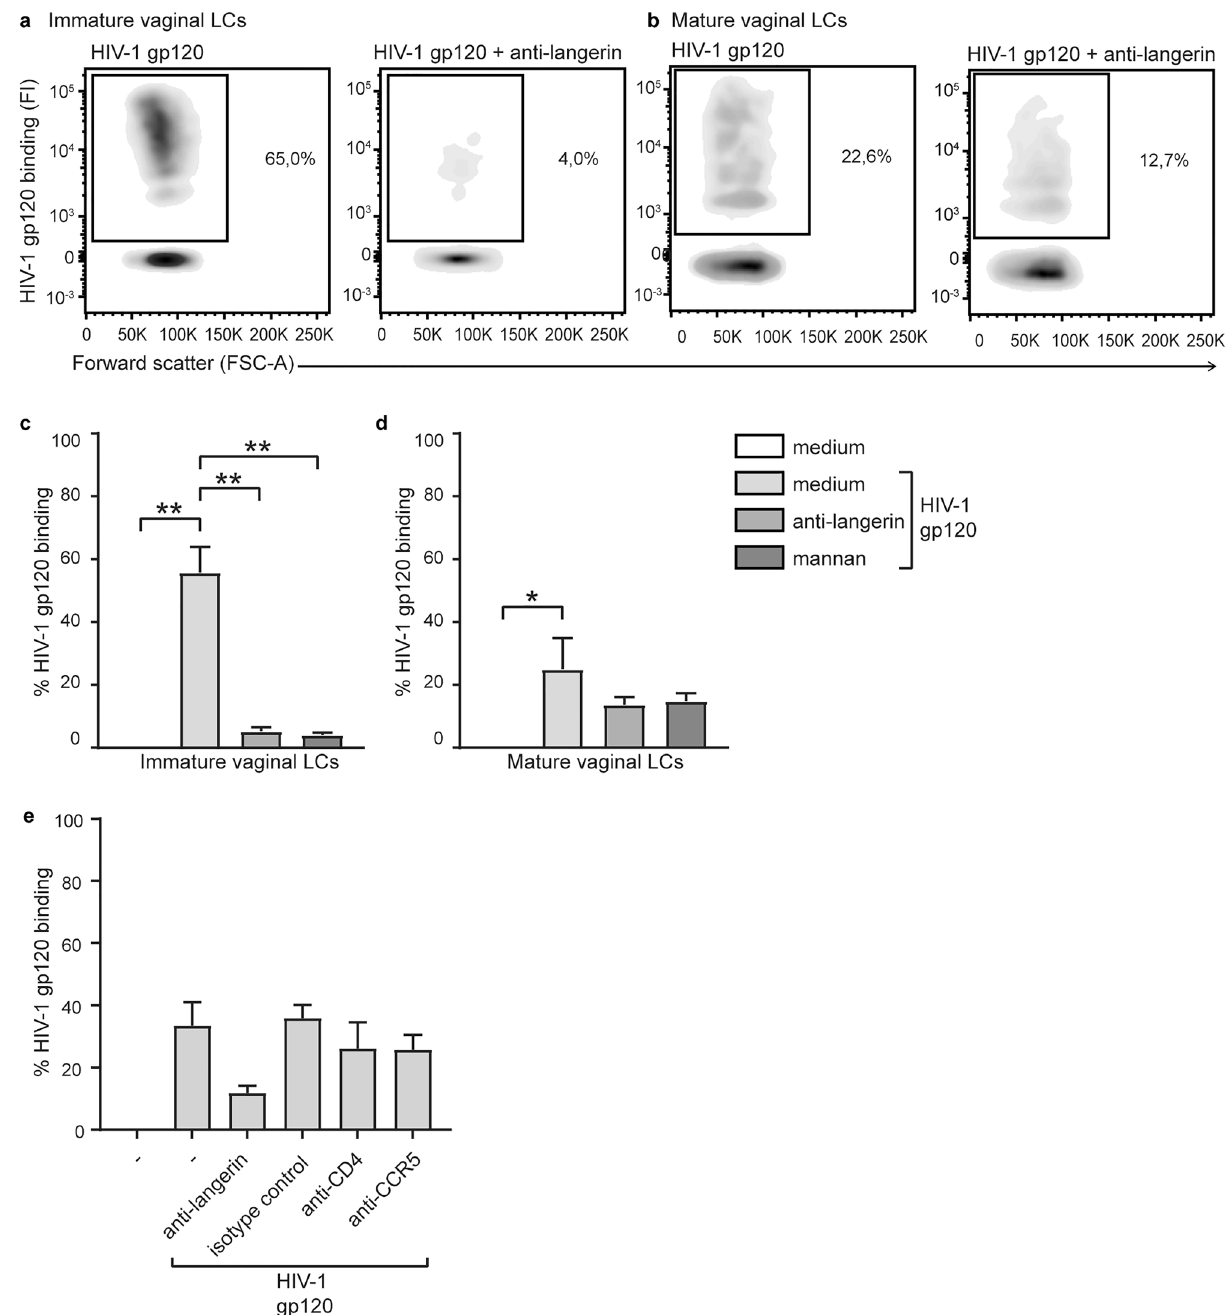
Figure 4. Immature vaginal LCs efficiently engage HIV-1 through langerin. ( a,b ) representative flow cytometry plots of HIV-1 gp120 binding to immature ( a ) and mature ( b ) vaginal (CD1a + , Langerin high ) left untreated or pre-treated with anti-langerin; ( c,d ) pooled HIV-1 gp120 binding data (% HIV-1-gp120 +) of immature (( c ), N = 3) and mature (( d ), N = 3) vaginal LCs pre-treated with medium, anti-langerin, or mannan; * p < 0,05, ** p < 0.01, two-tailed t- test; (( e ), N = 2) GP120 binding (% HIV-1-gp120 +) on immature vaginal LCs in the presence or absence of anti-langerin (10E2), anti-DC-SIGN (D1, isotype control), anti-CD4 or anti-CCR5 blocking antibody; data are mean ±